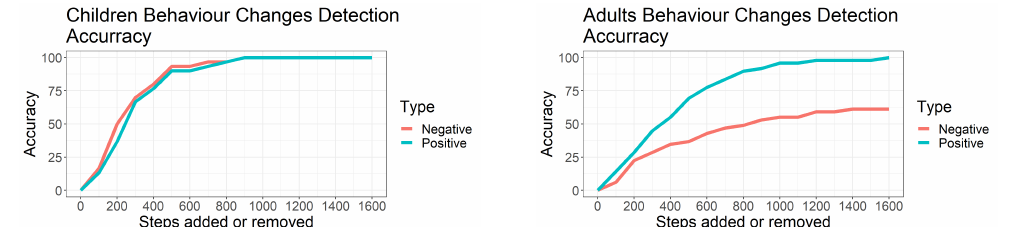
Figure 5. Left and right graph show behaviour-change detection accuracy of children and adults, respectively. X − axis indicates number of steps added at 8 am as positive behaviour changes or removed at noon as negative behaviour changes. Y − axis indicates percentage of behaviour changes detected relative to all changes added. Red and blue lines indicate percentage of negative and positive behaviour changes detected,